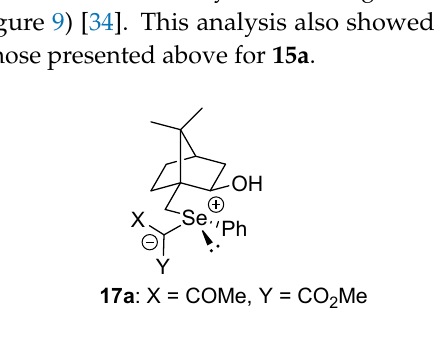
Figure 9. Selenonium ylide 17a containing the 2- exo -hydroxy 10-bornyl moiety.